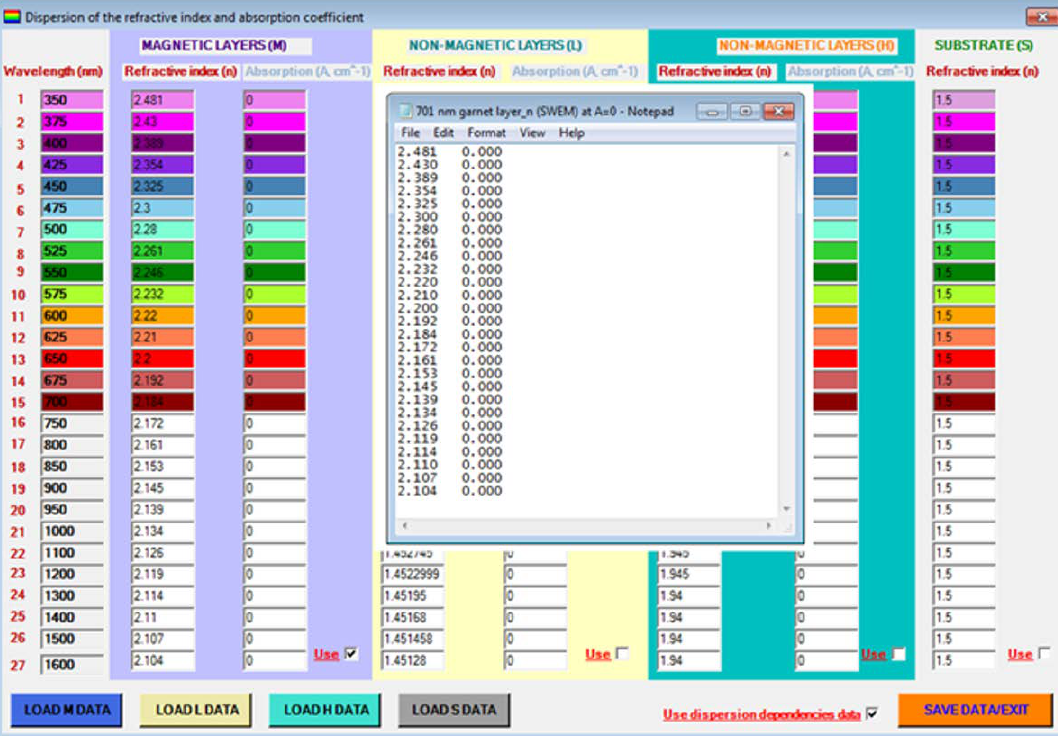
Figure 2. Form dedicated to loading the optical constants data from text files prepared as shown, using the software-specific 27-row wavelength grid and containing the columns data for the refractive index and optical absorption coe ffi cient (in cm − 1 ) at each wavelength point within the spectral